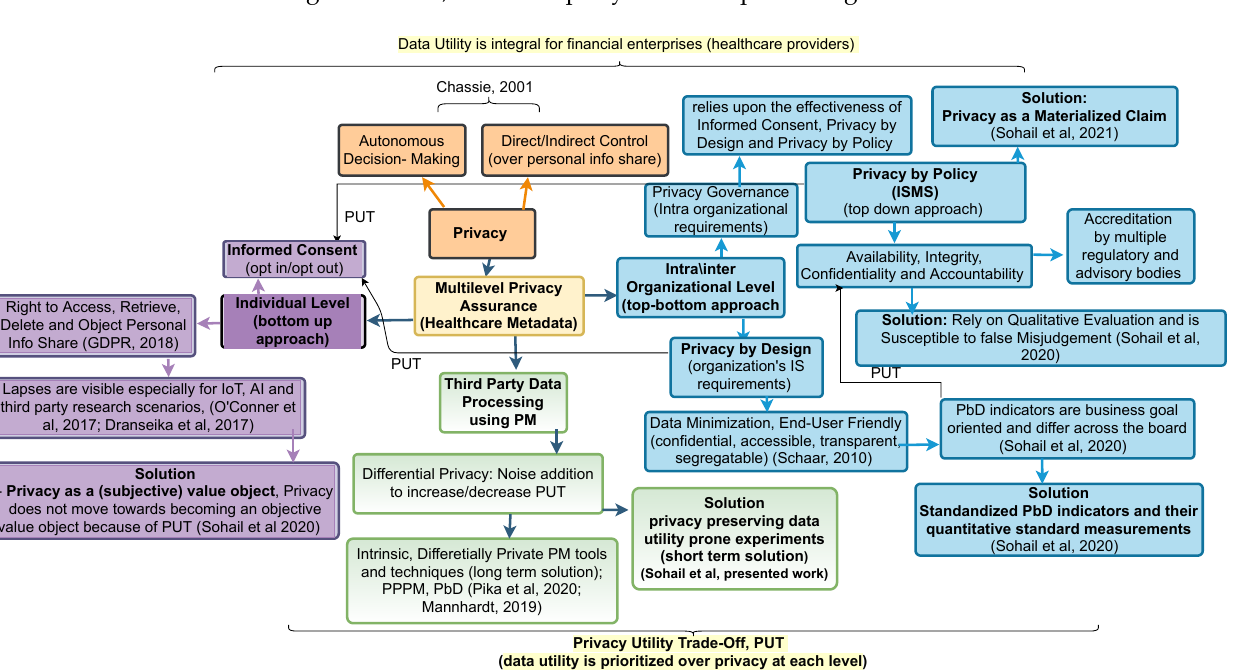
Figure 10. Contribution: Multilevel Privacy Assurance Evaluation and Privacy Utility